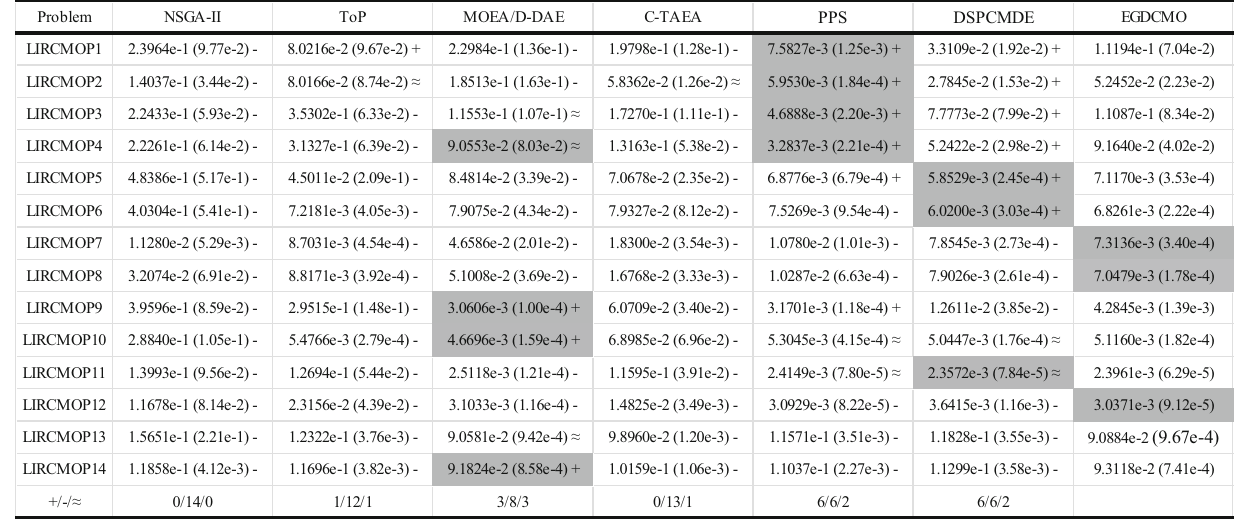
The best result in each row is highlighted. “N/A” indicates that no feasible solution is found Table 8 Statistics of the HV metric obtained by the proposed EGDCMO and all the compared CMOEAs on the LIR-CMOP problems